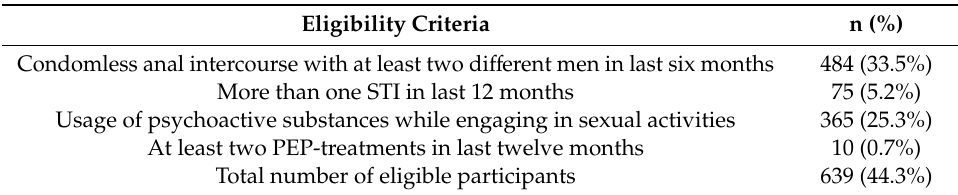
Table 2. Eligibility criteria for PrEP in